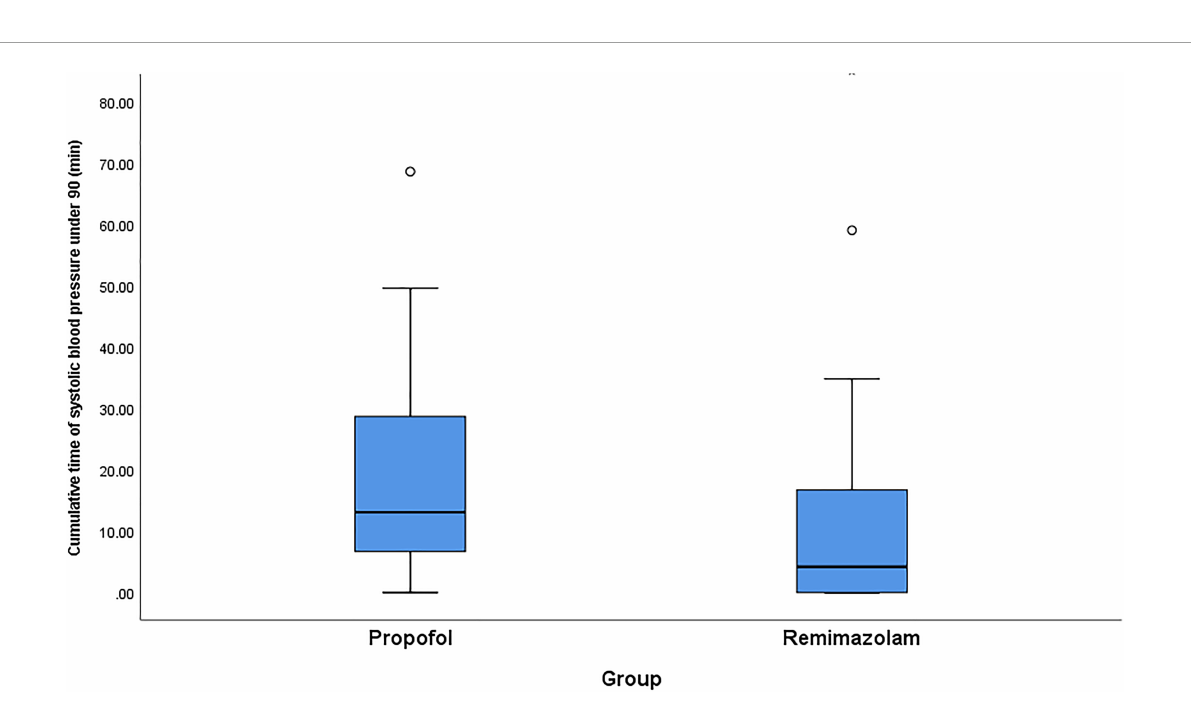
FIGURE3 Comparison of propofol and remimazolam on cumulative time of intraoperative hypotension. Boxplots are shown with the lines in the box representing median [Q1, Q3] of the observed cumulative time and the whiskers extended to the minimum at the bottom and the maximum on top. Q1 and Q3 represent 25th and 75th of the cumulative time of intraoperative